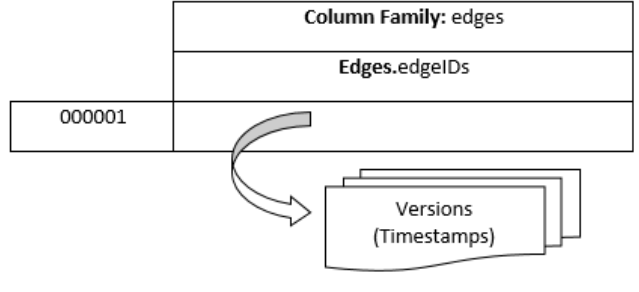
Figure 4. Spatial index data